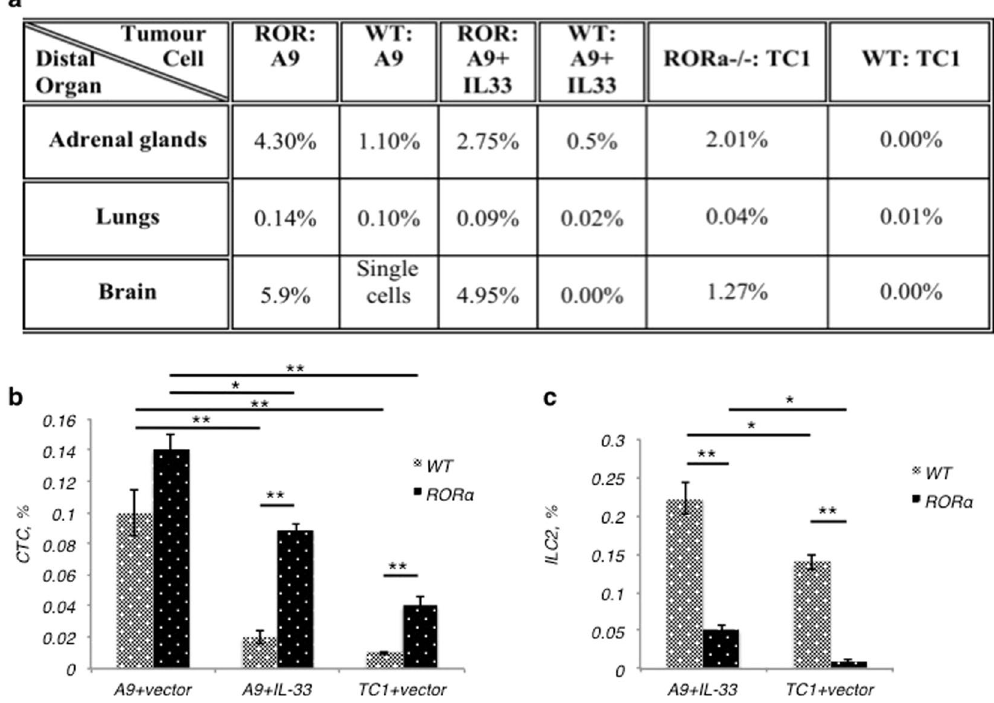
Figure 5. Functional ILC2 cells are important in controlling the metastatic spread of the tumours. ( a ) Spread of EGFP-positive circulating tumour cells (CTC) to distal organs was higher in chimeric mice lacking ILC2s (ROR α − / − mice); even primary TC1 cells that are not metastatic in the WT mice could be found beyond the initial site of transplantation in mice lacking ILC2s. ( b ) In lungs, CTC counts were higher in animals with reduced number of ILC2s (ROR α − / − ). ( c ) The number of ILC2s present in the lungs appeared to go up with the presence of CTCs in the lungs. The percentage of all cells was calculated from the fraction of live cells in 2 × 10 5 events used to create a profile for each organ; n = 8 mice per group; * P < 0.05; ** P <